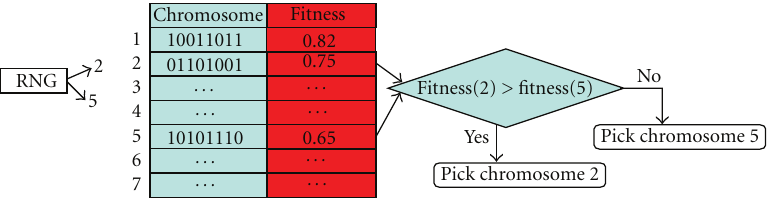
Figure 6: A tournament scheme for the parent selection in the GA.